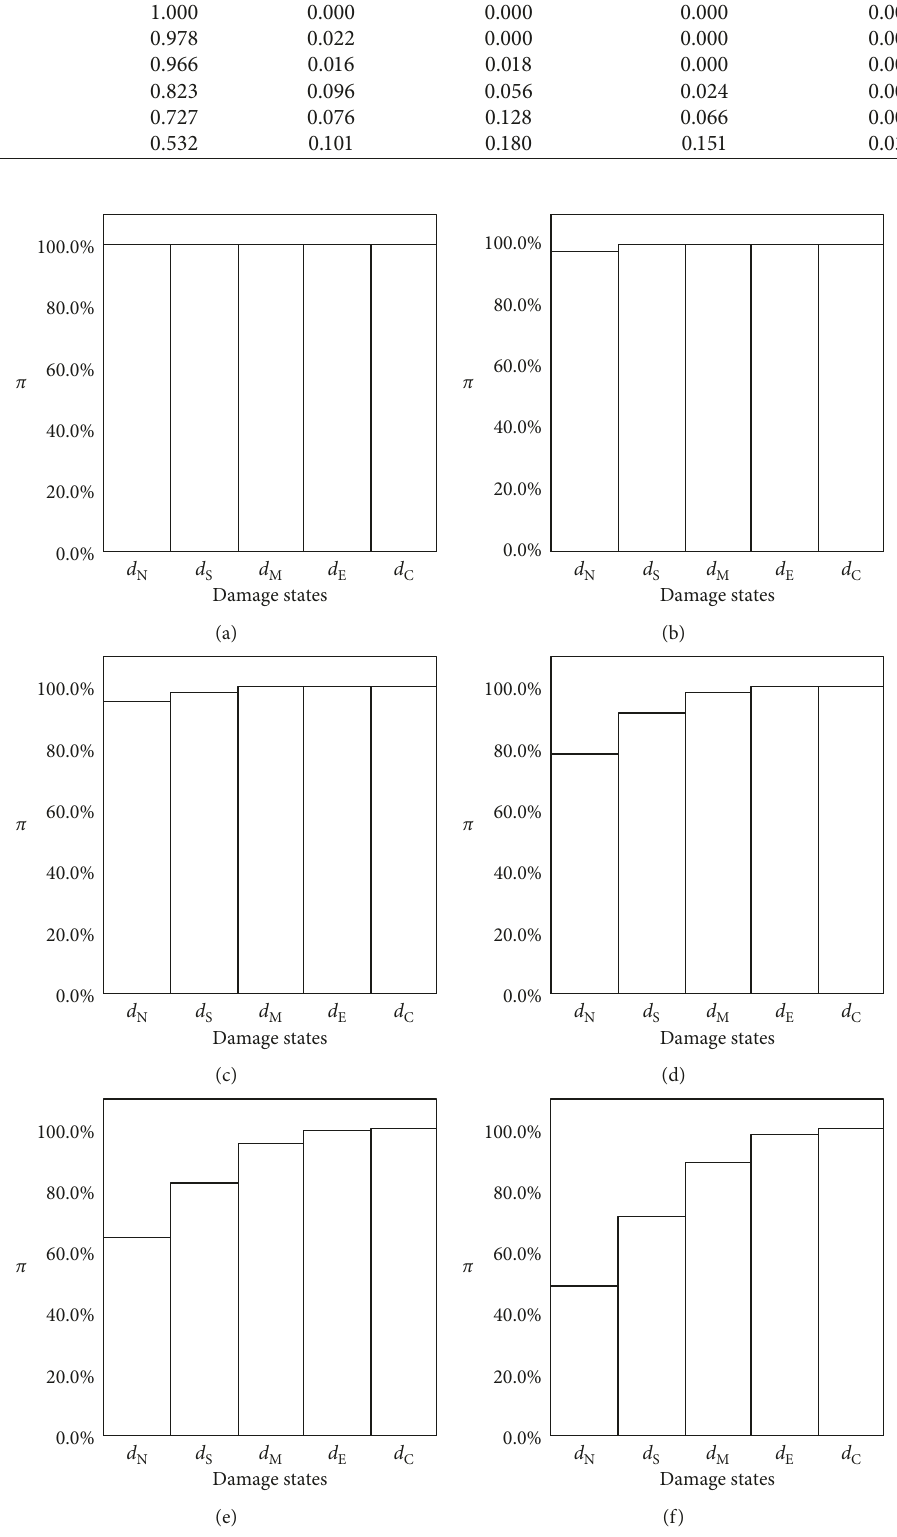
Figure 4: Possibility distributions of damage states for the corresponding PGA (g) intervals. (a) [0.069, 0.079]g. (b) [0.080, 0.137]g. (c) [0.138, 0.322]g. (d) [0.323, 0.384]g. (e) [0.385, 0.680]g. (f) [0.682,